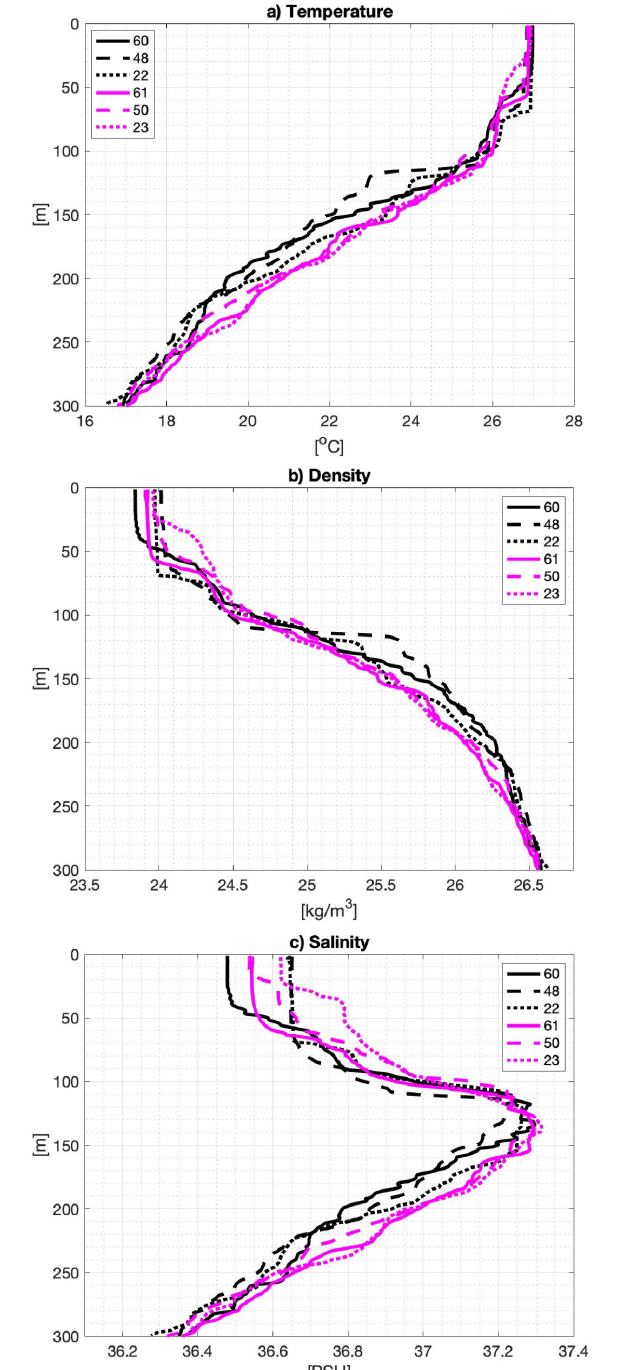
Figure 2. Characteristic profiles of: ( a ) temperature, ( b ) density, and ( c ) salinity. Black profiles correspond to shallow stations and magenta profiles to deep